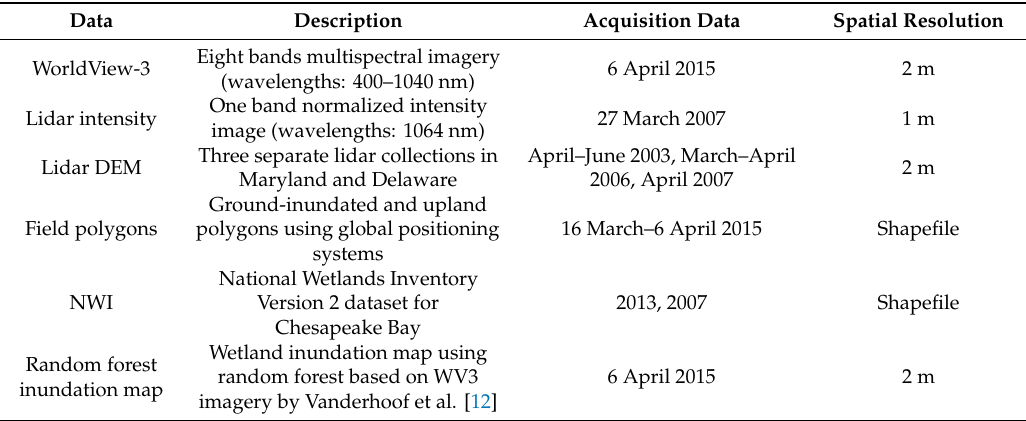
Figure 1. Map of study area in the upper Choptank River watershed located in the Delmarva Peninsula, USA. ( a ) The 2-m WorldView3 (WV3) imagery (acquisition date: April 6, 2015) in a natural color composite. ( b ) The 2-m light detection and ranging (lidar) digital elevation model (DEM) generated from three separate lidar collections. ( c ) Topographic wetness index (TWI) derived from the 2-m lidar DEM, which was generated from the System for Automated Geoscientific Analysis (SAGA) v. 7.3.0. Table 1. Datasets used in this